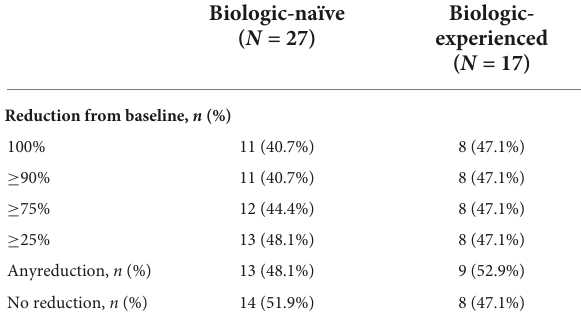
TABLE 3 Oral corticosteroid (OCS) reduction at end of observation in the patient